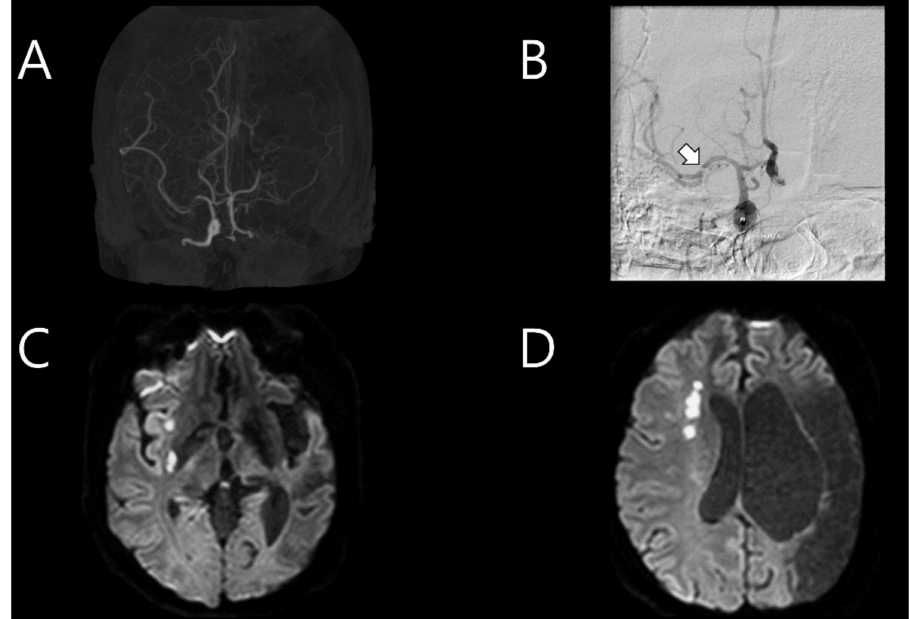
Figure 2. ( A ) Brain computed tomography angiography conducted on the second event which occurred after 5.5 years, showing recently formed severe stenosis in the M1 portion of the right middle cerebral artery (MCA), with left MCA occlusion present from the past stroke event. ( B ) Immediate cerebral angiography showing intramural hematoma and intimal flap in the M1 portion (arrow) of the right MCA. ( C , D ) Follow-up brain magnetic resonance imaging showing a multifocal acute infarction in the right MCA